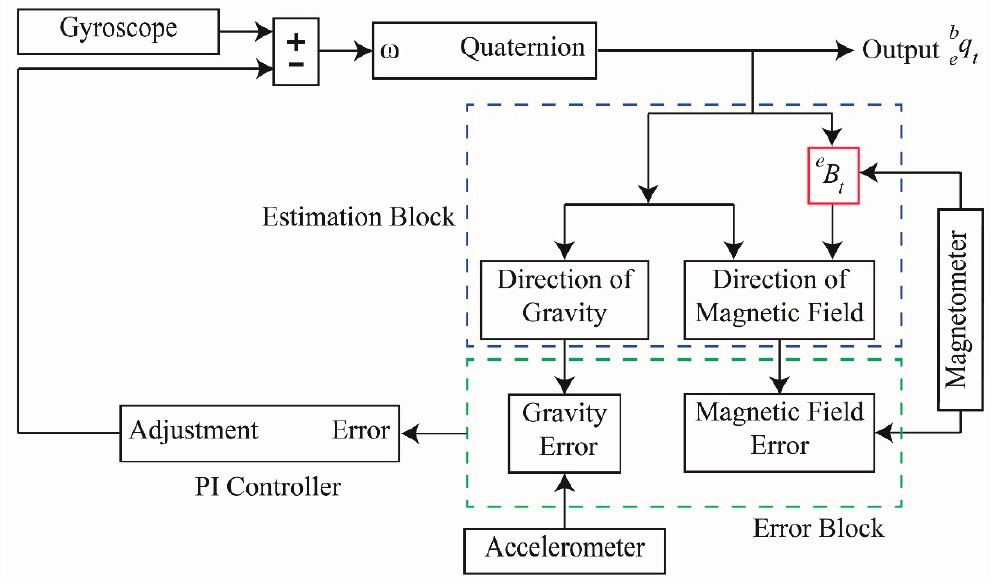
Figure 3. Complementary filter block